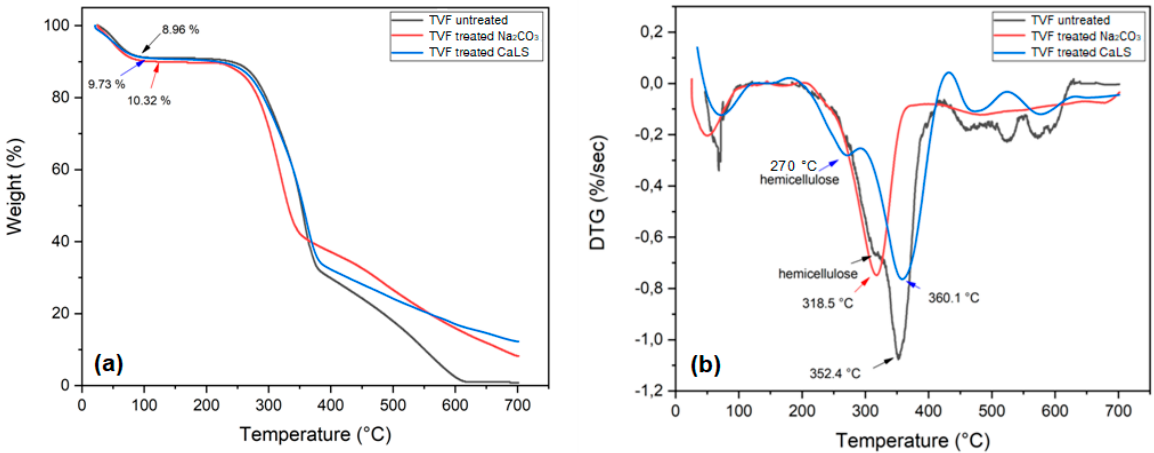
Figure 4. ( a ) TG curves for treated and untreated TVFs; ( b ) DTG curves for treated and untreated TVFs.